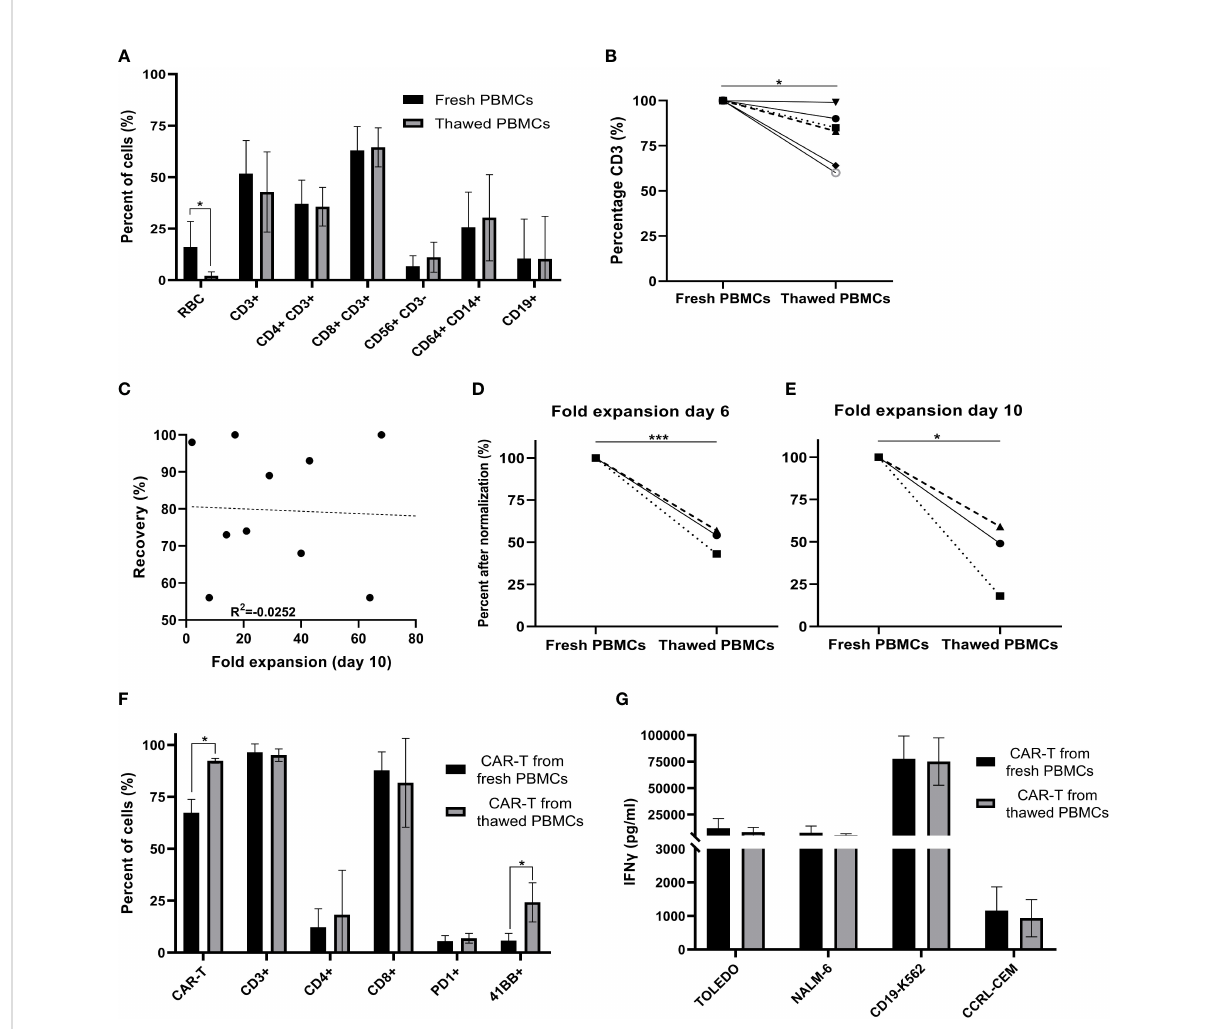
FIGURE 1 Comparison of fresh versus cryopreserved PBMCs. (A) Fresh PBMC and cryopreservation/thawed PBMCs subpopulation composition markers, were analyzed by fl ow cytometry (RBC; red blood cells) (n=6). (B) % CD3+ T cells in fresh PBMCs and thawed PBMCs after normalization (fresh PBMCs = 100%) (n=6). Each symbol represents a single patient ’ s product. (C) Spearman ’ s rho correlation between the recovery (%) after thawing and the fold expansion achieved by the end of the production process. (n=10). Each dot represents a single patient ’ s product. (D, E) Fold expansion on day 6 and day 10 after normalization (fresh PBMCs = 100%). Average fold expansion ± SD in comparison to the number of